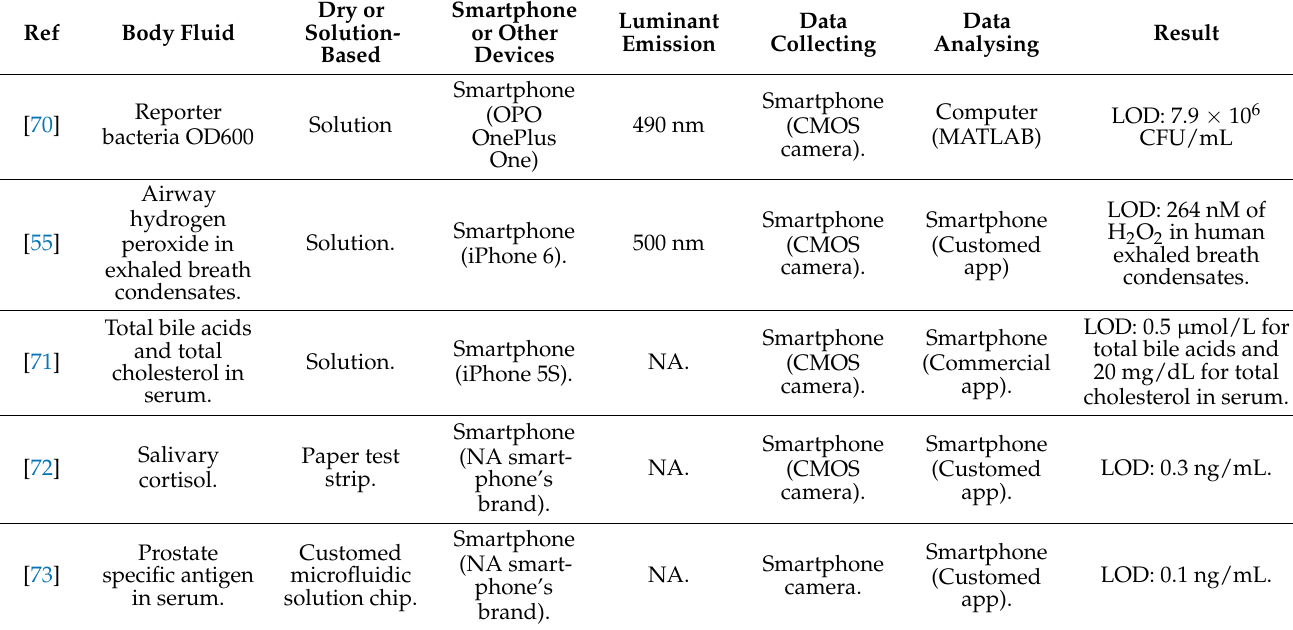
Table 6. Portable devices using the chemiluminescence method to detect biomarkers in body